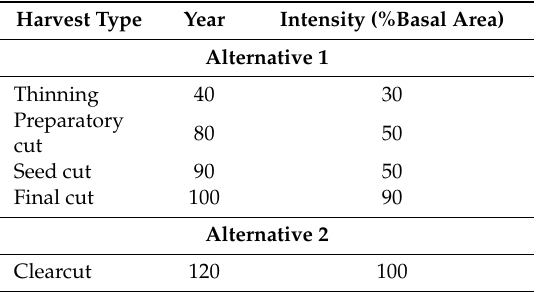
Table 5. Management alternatives